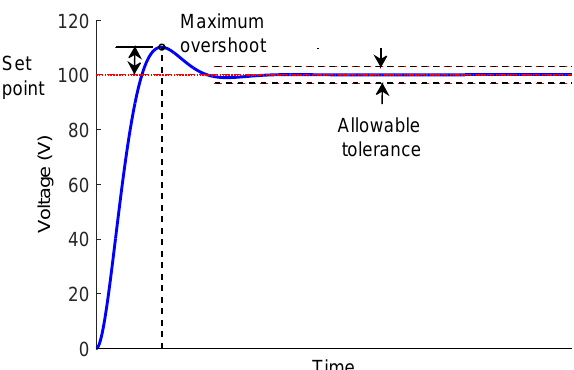
Figure 7. Three primordial characteristics response for the DC-HV DC converter in automatic pipeline